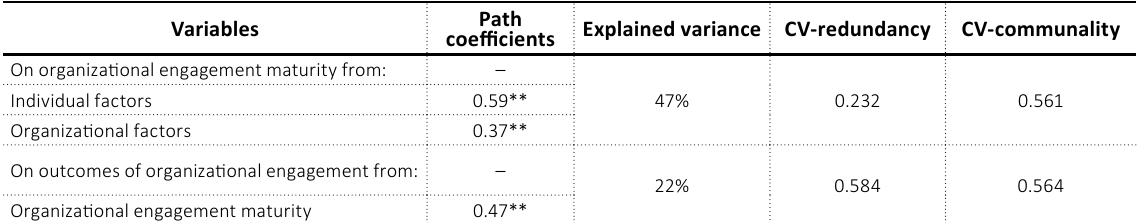
Table 1. The path coefficients and explained